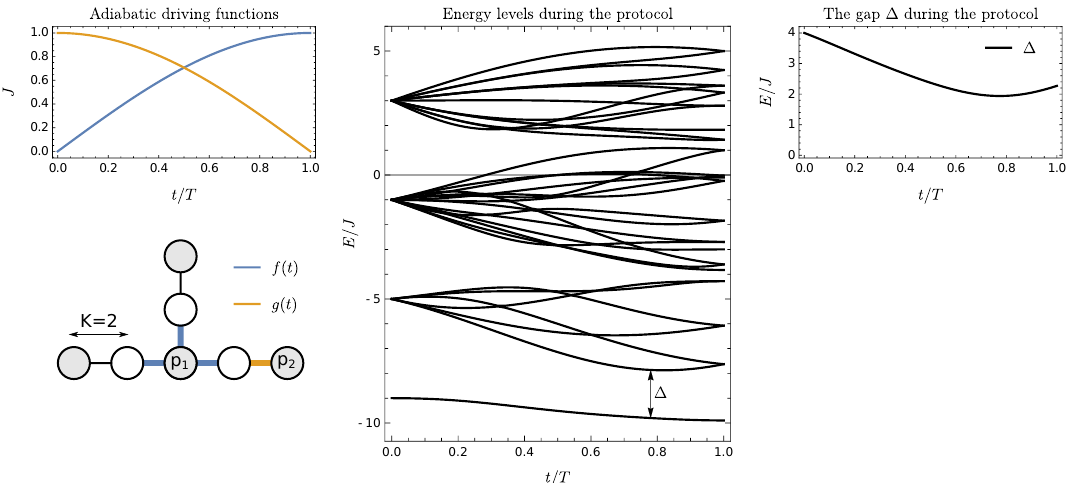
Figure 5: For the adiabatic transfer protocol in a system of size M = 3 and K = 2, we display the driving functions f and g and a sketch of the star-shaped system (left), the lowest 10 energy levels (middle) and the size of the energy gap (right) as a function of time. All units are normalized with respect to the protocol time T and the coupling strength J